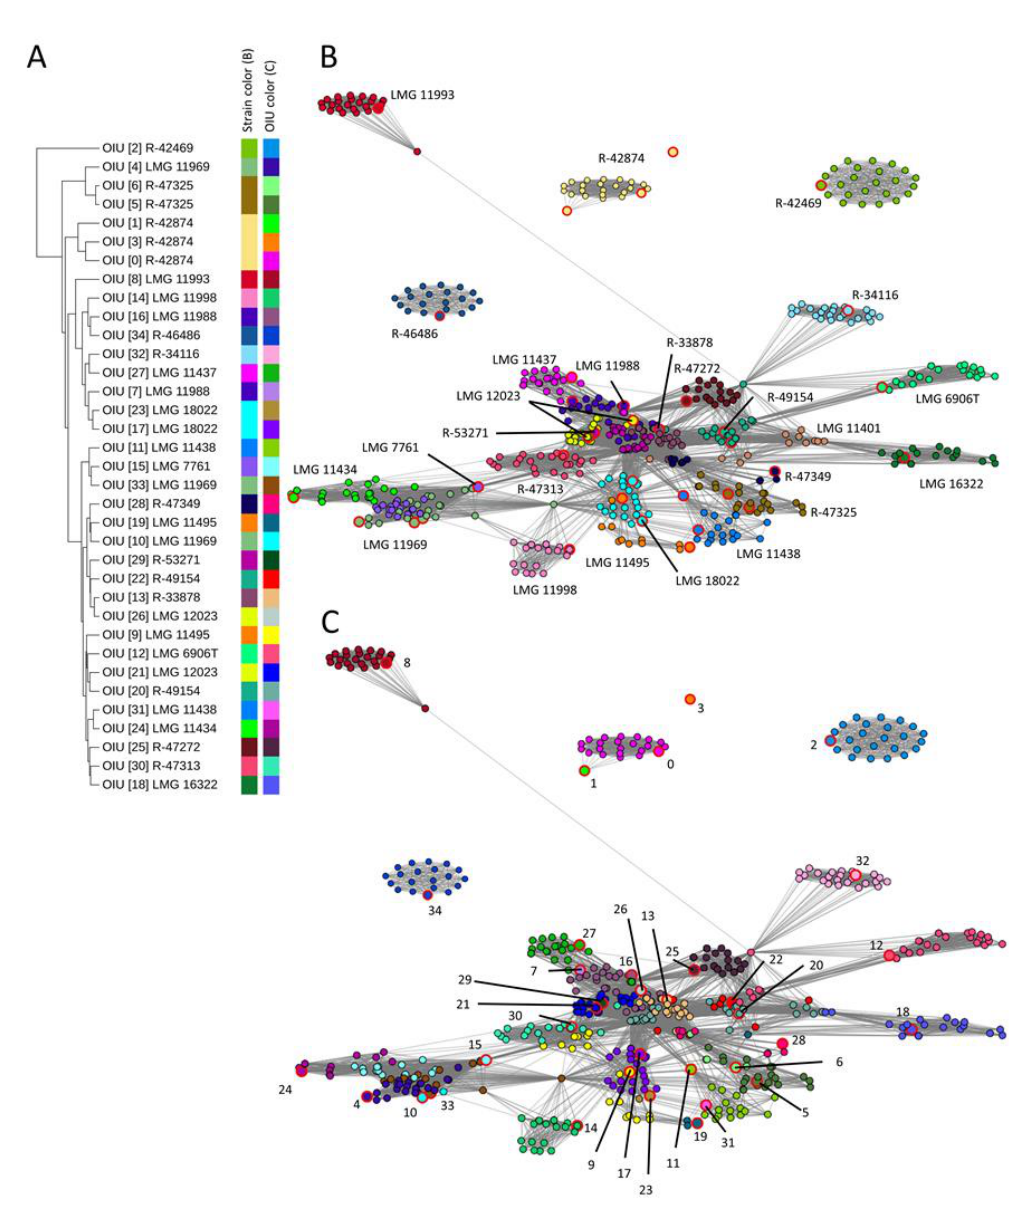
Figure 1. Comparison of hierarchical clustering versus network analysis of the L. brevis dataset. ( A ) Hierarchical clustering dendrogram of 35 reference spectra (UPGMA algorithm) using the relative distance in the number of detected USFs. Color bars depict strains and OIUs. ( B ) Network analysis based on all zero USFs elements (edges) of the USF matrix. The individual nodes are colored according to the strain number, as depicted in panel ( A ). ( C ) Network analysis based on all zero USFs elements (edges) of the USF matrix. Individual nodes are colored according to OIU number, as depicted in panel ( A ). The reference spectrum of each OIU is highlighted with large node sizes and red marking ( B , C ).